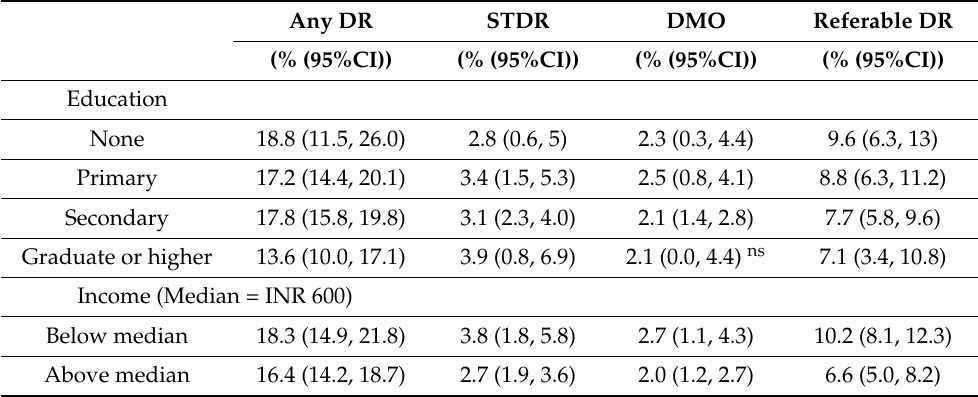
Table 4. Age- and gender-standardised prevalence of DR in socio-demographic groups ( N = 4527). Any